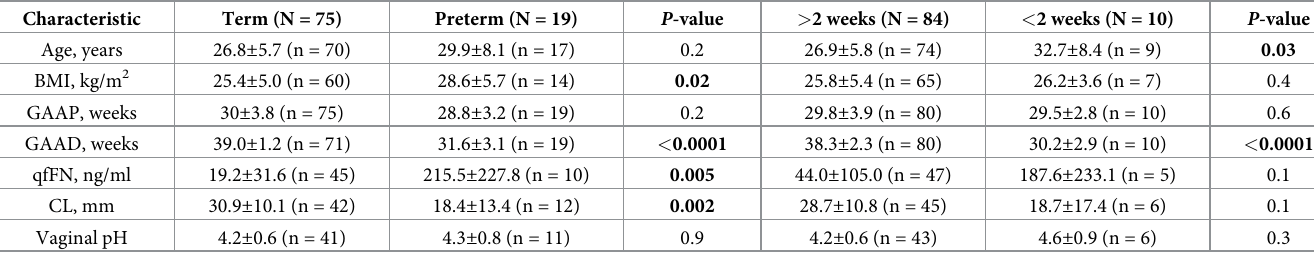
Table 1. Maternal clinical and demographic details according to delivery outcomes.